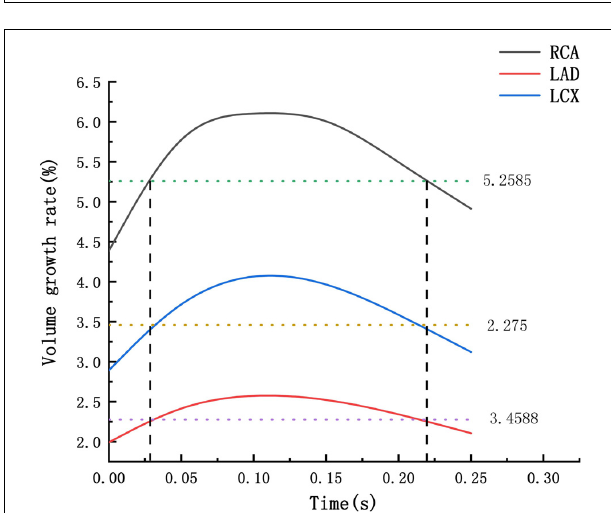
FIGURE 9 | Average volume growth rate: AS1: the Young’s modulus of the atherosclerotic site is 0.27MPa; AS2: the Young’s modulus of the atherosclerotic site is 0.027 MPa.